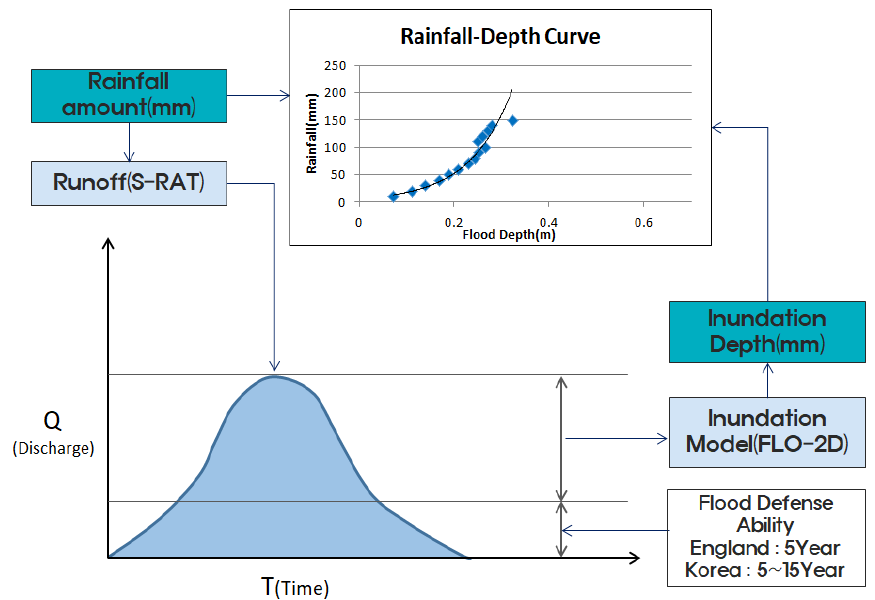
Figure 12. Conceptual diagram of rainfall – depth curve.